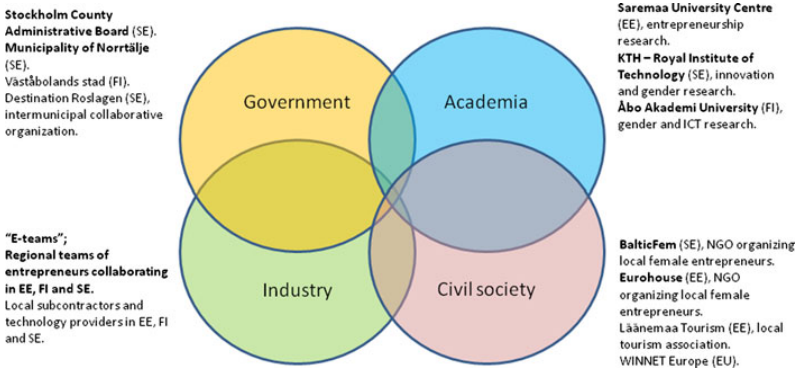
Fig. 1 Collaborative innovation architecture